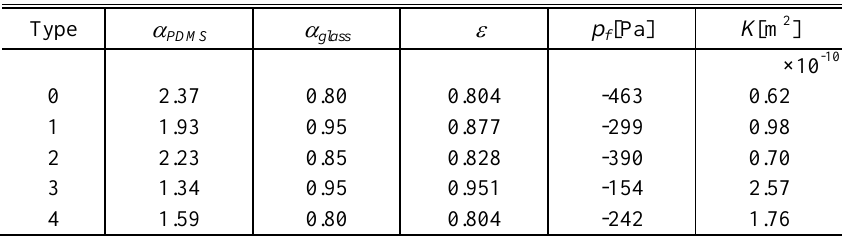
Fig. 7 Geometry for calculation of capillary pressure p and the projected area A . The surfaces are forced to be wetted by external work proportional to p of the water-air